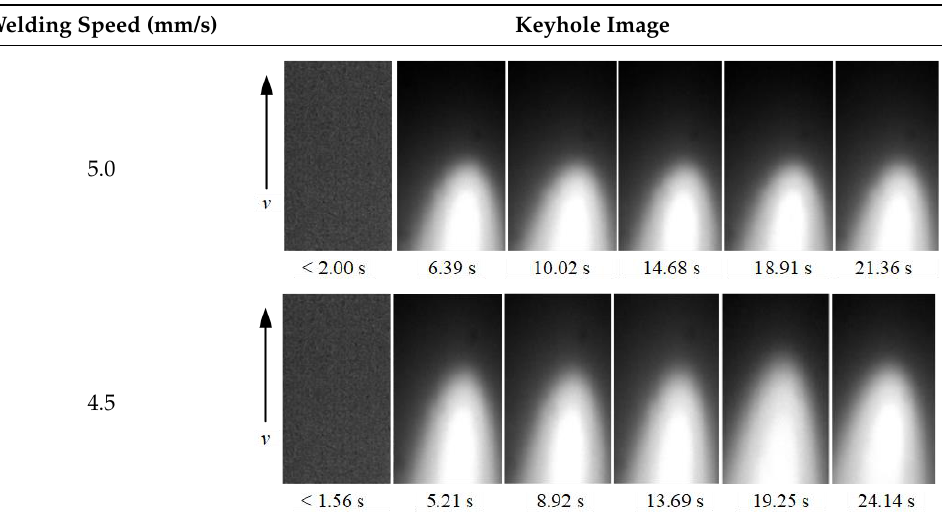
Table 2. Keyhole image on the back of the workpiece under different welding speeds.